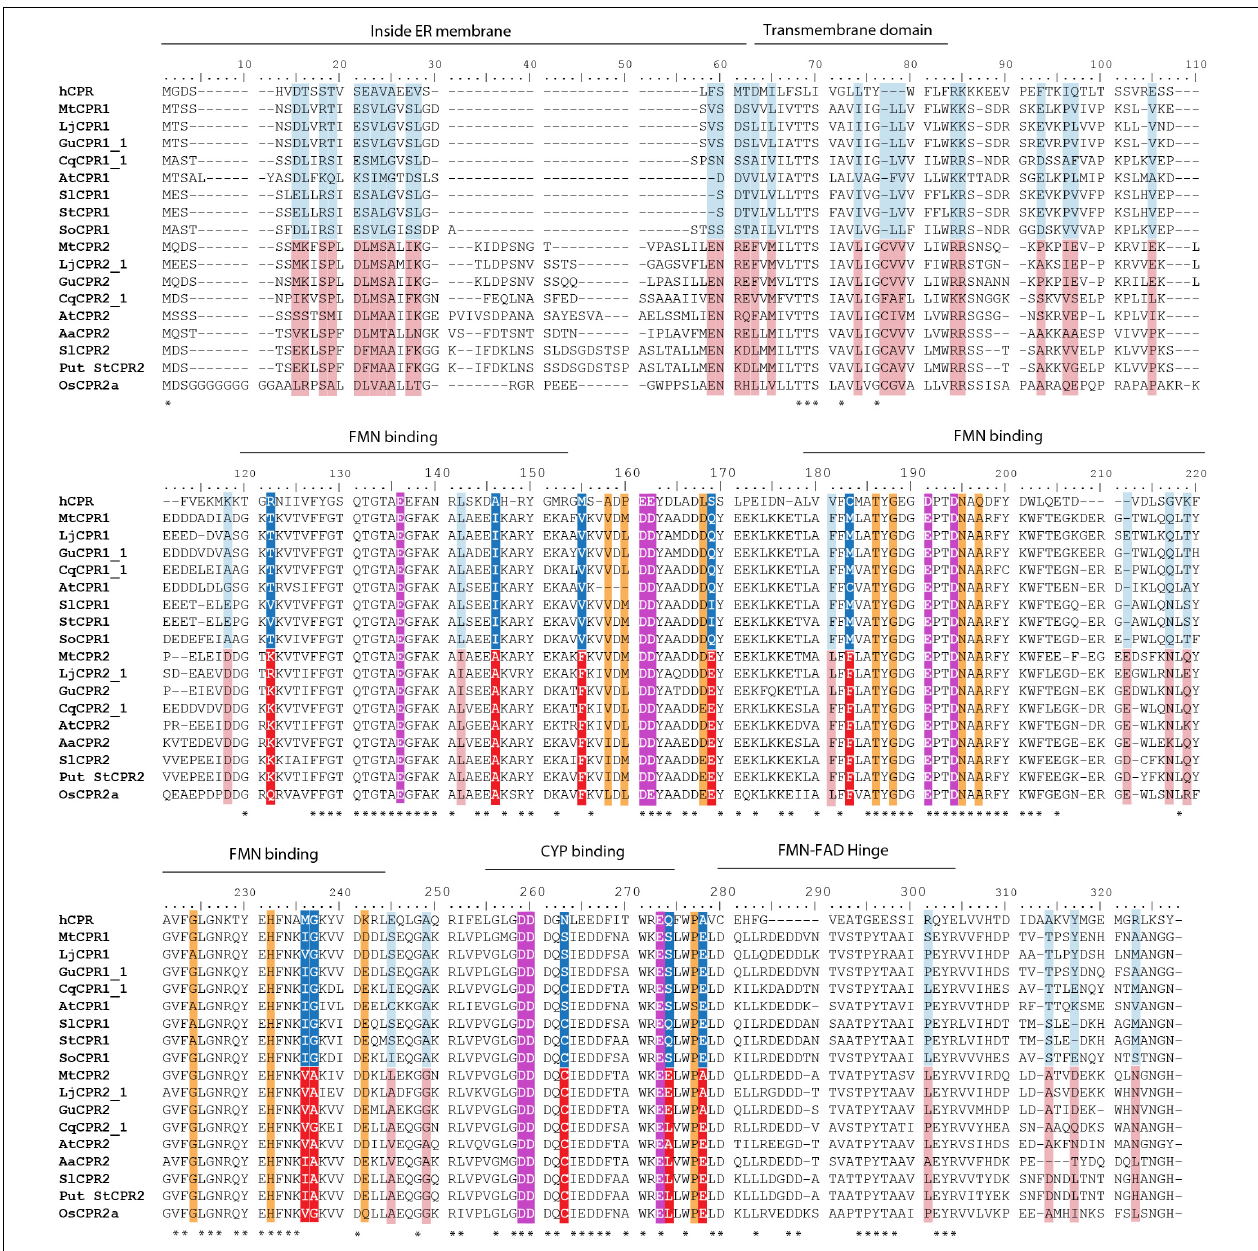
FIGURE 3 | Multiple sequence alignment of first 327 amino acids sequence of CPR class I and II containing N-terminal and FMN domains using the ClustalX color scheme for amino acid alignments. Dark blue, red, light blue, and pink colors indicate the different conserved amino acids in CPR class I and II in legume family based on motif analysis ( Supplementary Figure 2 ). Dark blue and red colors are the eight highlighted key residue in this study. Magenta color indicates acidic residue formerly reported to be important in CYP:CPR interaction in human CPR (hCPR). Orange color indicates point mutations in hCPR that are reported to improve interaction with a specific CYP. Asterisks indicate the positions which have a single, fully conserved residue. CPR, cytochrome P450 reductase; Aa, Artemisia annua ; ATR1, Arabidopsis thaliana CPR1 ; ATR2, Arabidopsis thaliana CPR2 ; Ca, Cicer arietinum ; Cq, Chenopodium quinoa ; Gu, Glycyrrhiza uralensis ; Lj, Lotus japonicus ; Mt, Medicago truncatula ; Os, Oryza sativa ; Sl, Solanum lycopersicum ; St, Solanum tuberosum.